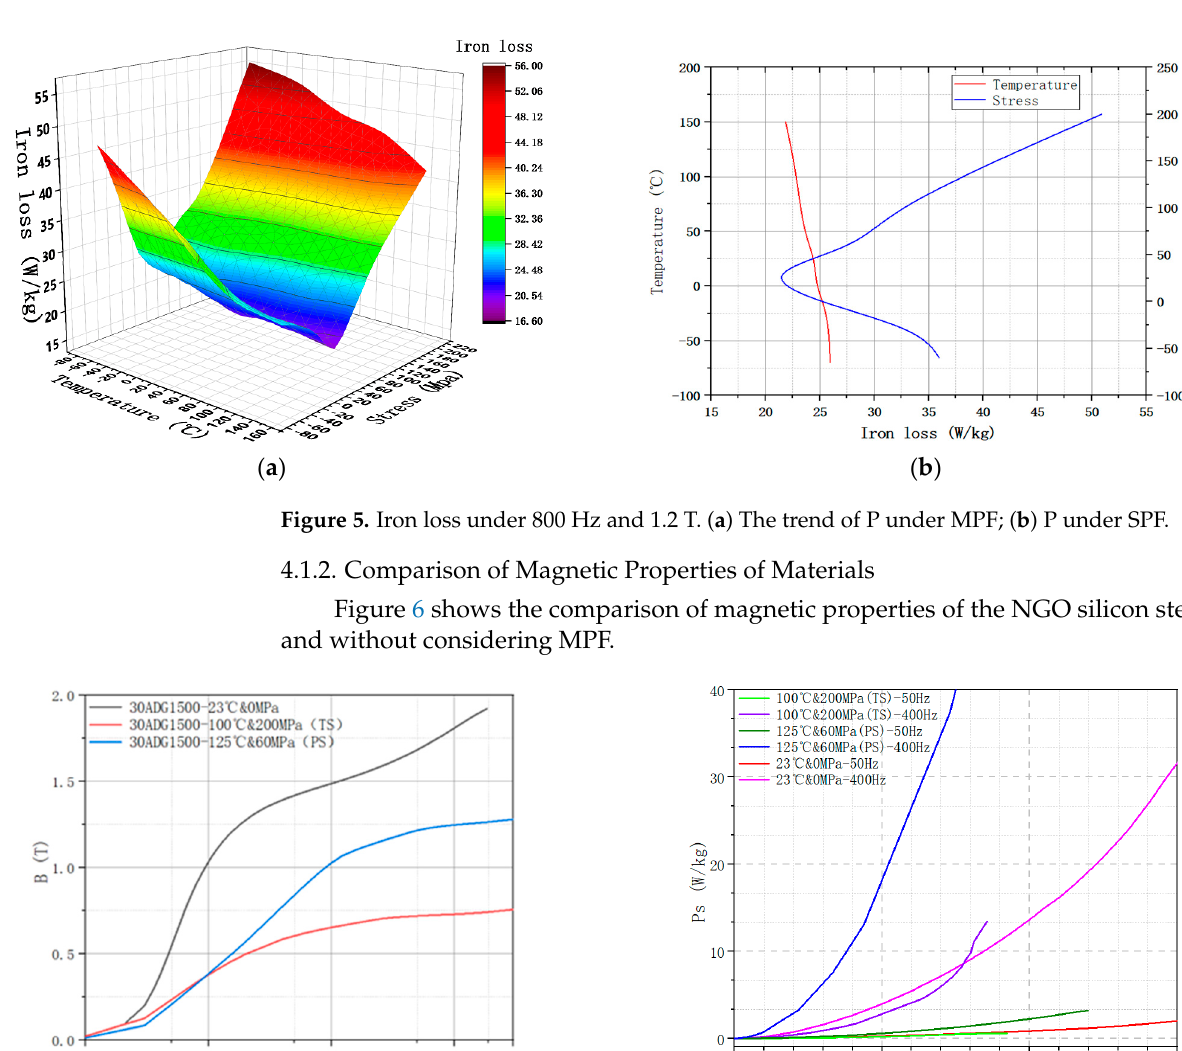
Figure 6. The magnetic characteristic of NGO silicon steel. ( a ) B-H curves; ( b ) B-P curves.